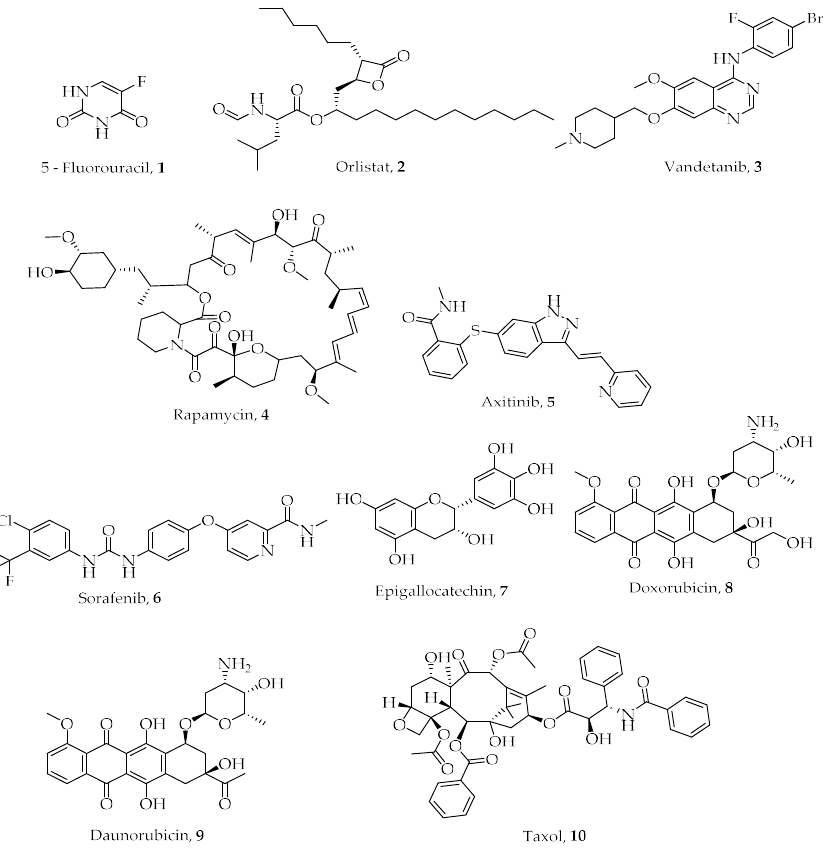
Figure 1. Chemical structures of some heterocyclic compounds used for treating various types of cancer.